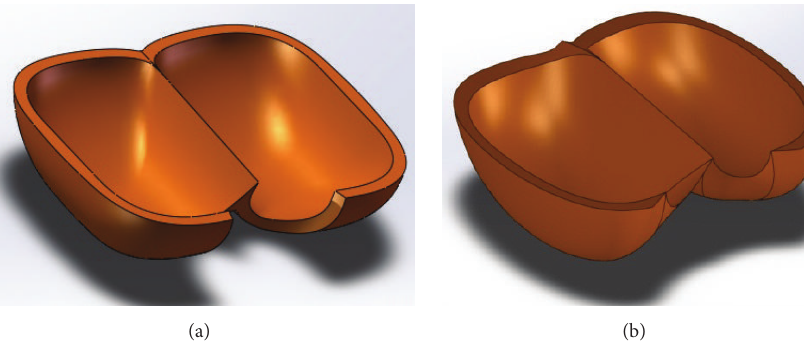
Figure 18: Comparison of the reference bucket (a) and the modified bucket design (b).